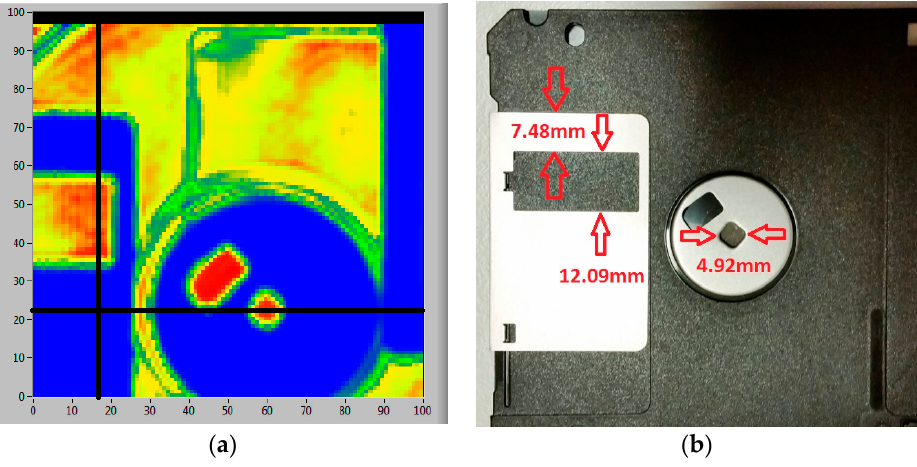
Figure 4. ( a ) A transmission image of a computer floppy disk; a scanned area of 50 mm × 50 mm at a resolution of 0.5 mm. The black lines indicate the single line scans at vertical line 17 and horizontal line 23; ( b ) is the photograph of the floppy disk flipped to correspond to scanned image.